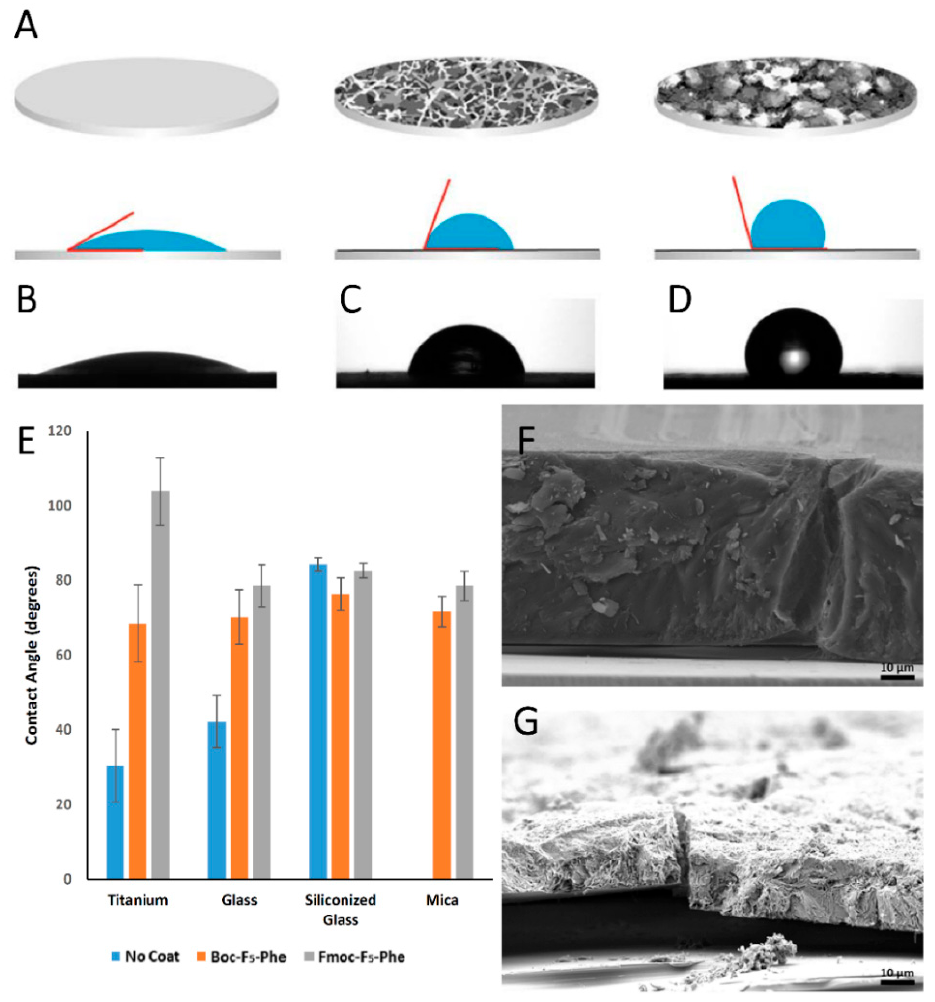
Figure 3. Surface properties of the Boc-F 5 -Phe and Fmoc-F 5 -Phe-coated discs. ( A ) Schematic view (top) and contact angle analysis of a 2 µL water droplet (bottom) of non-coated, Boc-F 5 -Phe-coated and Fmoc-F 5 -Phe-coated surfaces. The water droplet (blue), the black lines represents the coating on the surface and the red lines depict the contact angle. ( B – D ) Image of a water droplet on ( B ) a non-coated, ( C ) Boc-F 5 -Phe- and ( D ) Fmoc-F 5 -Phe- coated titanium surface. ( E ) Water contact angle measurements of non-coated, Boc-F 5 -Phe- and Fmoc-F 5 -Phe- coated titanium, glass, siliconized glass and mica ( n = 3). ( F ) SEM image of the surface morphology and thickness of siliconized glass coated with Boc-F 5 -Phe ( G ) SEM image of the surface morphology and thickness of siliconized glass coated with Fmoc-F 5 -Phe (Scale bar 10 µm).